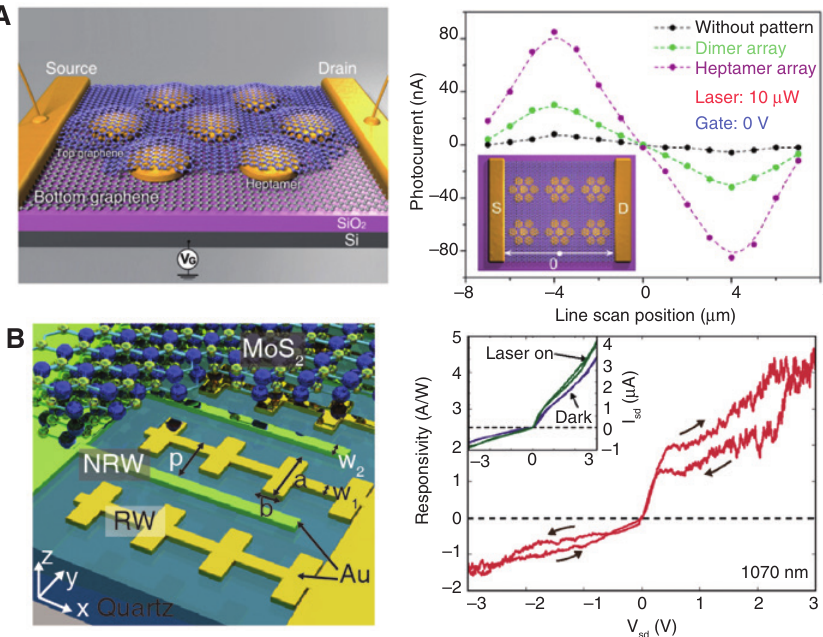
Figure 5: Hot electron photodetection based on 2D materials. (A) Left: Schematic of a graphene-antenna sandwich photodetector. Right: Photocurrent characterization of the graphene-antenna sandwich photodetector showing that the heptamer array is more efficient than a dimer array. (B) Left: Schematic of the Au-MoS in which the yellow Au structures are resonant, whereas the green Au structures are nonresonant. Right: Photoresponsivity as a function of source-drain voltage (V ) measured at 1070 nm. The inset shows the source-drain current (I sd and in a dark environment. Figures adapted with permission from: (A) Ref. [139], ©2012 American Chemical Society; (B) Ref. [145], ©2015 American Chemical